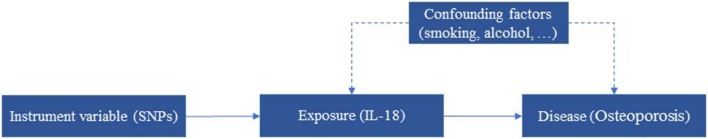
MR analysis using SNPs as instrumental variables for estimating the influence of IL-18 on the risk of Osteoporosis.